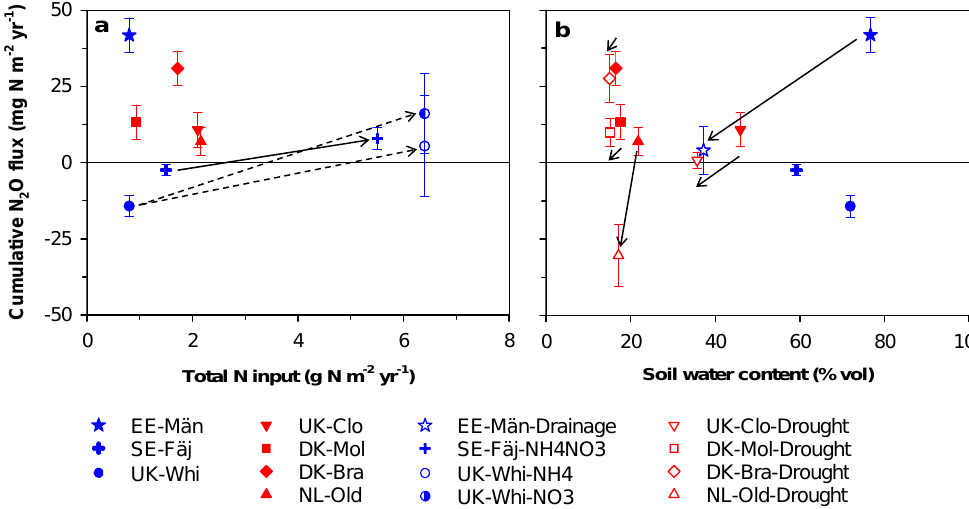
Fig. 6. Annual N 2 O flux at seven sites related to atmospheric N deposition (a) and mean annual soil water content, predominantly measured in the top 10cm soil layer (b) (means ± SE). In addition to data for control plots, results are presented for plots that were exposed to either increased N input (a) or drainage and drought (b) . Arrows indicate direction of treatment responses. Site codes are described in Table 1.